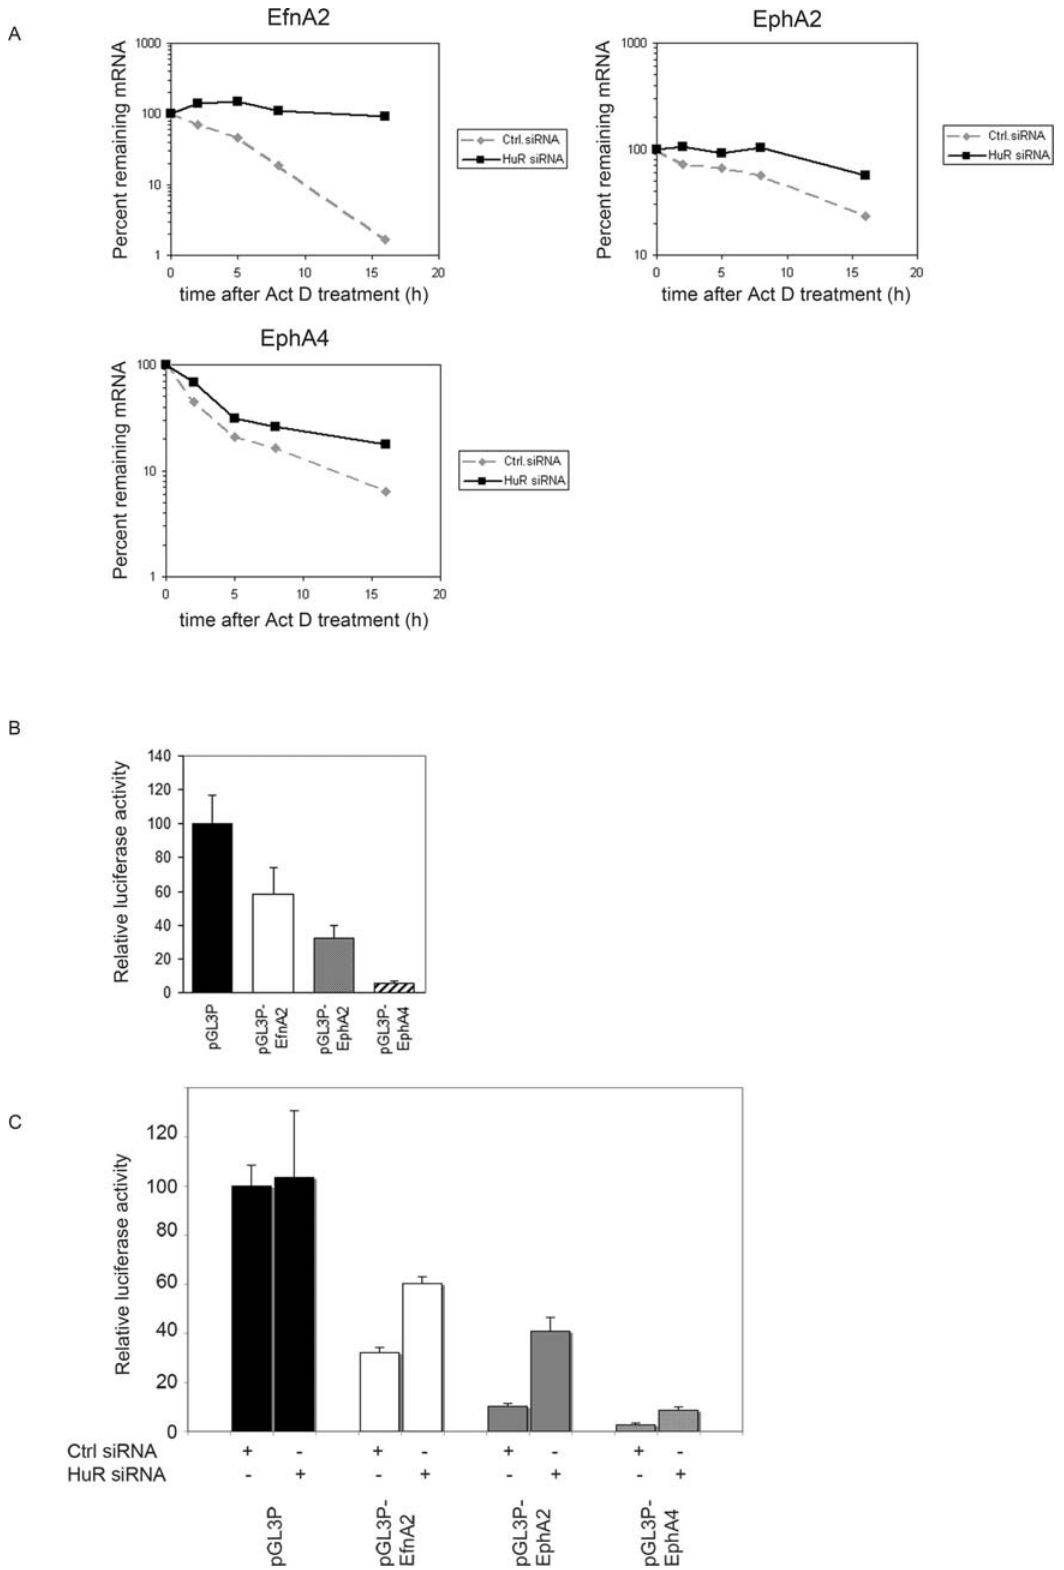
Figure 7. HuR is a direct regulator of Eph/ephrin mRNA stability. (A) 48 hours after transfection of a specific HuR RNAi oligonucleotide or a control oligonucleotide the half-lives of EfnA2, EphA2 and EphA4 mRNAs were assessed by using 5 m g/ml Actinomycin D; mRNA half-lives were measured by Real Time RT-PCR, mRNA expression was normalized to GAPDH. (B) 3’terminal parts of EfnA2, EphA2 and EphA4 3’UTRs were cloned in pGL3 promoter vector and transfected into HeLa cells. 30 hours after transfection cells were harvested and firefly luciferase activity was measured.